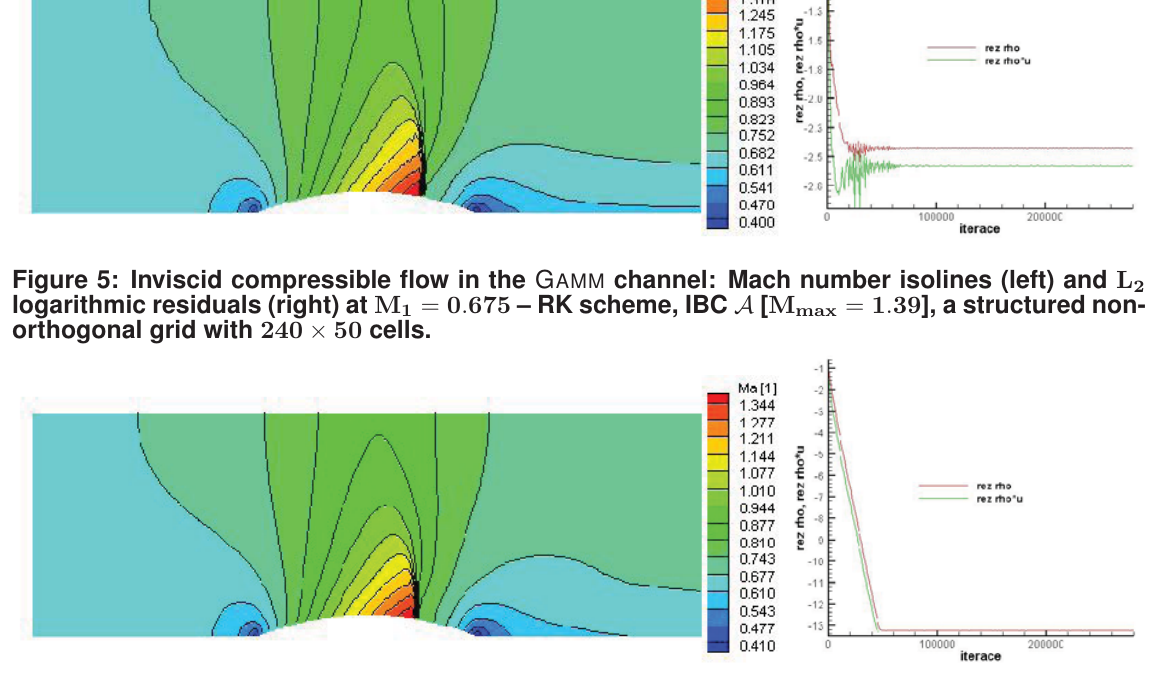
Figure 6: Inviscid compressible flow in the G AMM channel: Mach number isolines (left) and L 2 logarithmic residuals (right) at M 1 = 0 . 675 – RK scheme, IBC B [ M max = 1 . 34 ], a structured non- orthogonal grid with 240 × 50